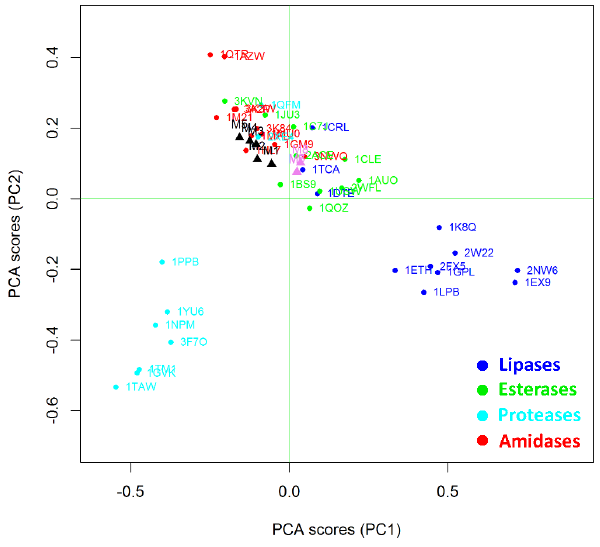
Figure 9. Unsupervised Pattern Cognition Analysis (UPCA) of BioGPS descriptors generated by N1 probe (H-bond acceptor capabilities). The analyzed enzymes are labelled according to their PDB code and colored as in figure 3. Improved mutants are highlighted as black triangles and poor mutants are pink triangles.